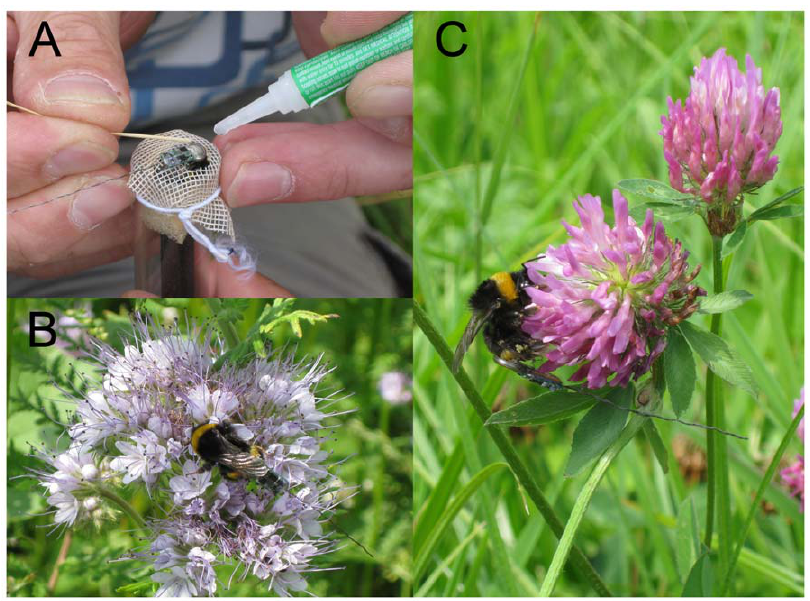
Figure 1. Miniaturized radio transmitters attached to bumblebees. ( a ) Transmitter attachment on a Bombus terrestris individual kept in a glass tube with opened gauze where the transmitter is fixed with superglue. ( b ) Nectar collecting individual of Bombus terrestris on Phacelia flower having a transmitter attached. ( c ) Bombus terrestris individual with attached transmitter, foraging on red clover ( Trifoliumpratense ).